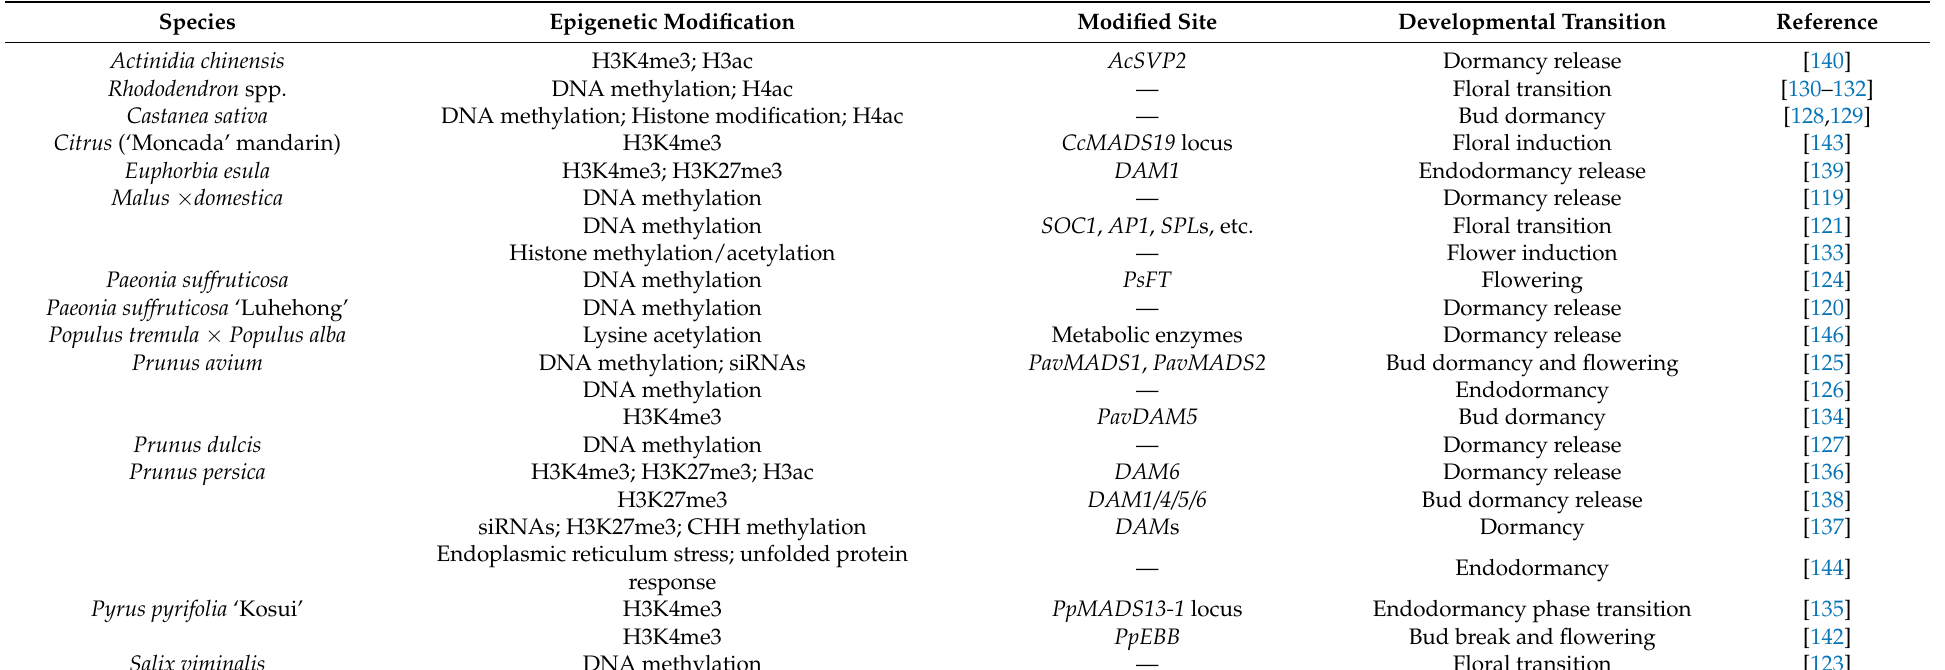
Table 3. Epigenetic regulation of flowering in woody